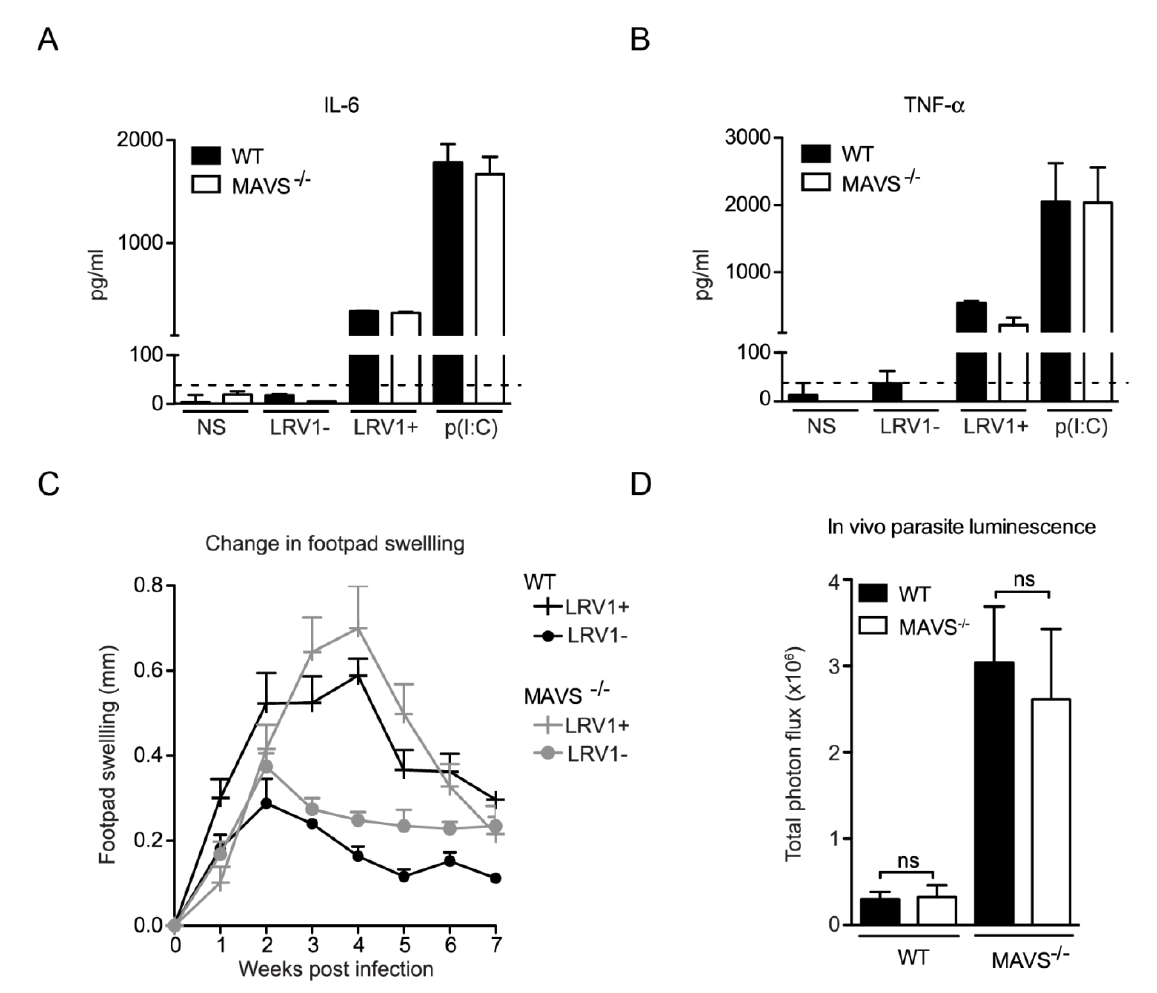
FIGURE 1: LRV1 does not activate RLR signaling. (A, B) BMDMs from mice deficient in MAVS and their C57BL/6 WT counterparts were in- fected with LgyLRV1+ or LgyLRV1- parasites or stimulated with a synthetic TLR3 ligand, poly(I:C). After 24 hours, the NF-  B cytokines, IL-6 (A) and TNF-α (B) in BMDM supernatant were quantified by ELISA. (C, D) MAVS -/- and C57BL/6 WT mice were infected with LgyLRV1+ or LgyLRV1- parasites in their hind footpads. (C) Weekly lesional swelling was monitored as a proxy for disease progression. (D) At the peak of infection (4 weeks), parasite burden was measured by in vivo luminescence, by injecting mice intra-peritoneally with 15 mg/kg luciferin. Data is representative of a minimum of three independent experiments, using at least five mice per condition, and showed as mean ± SEM. Significance tested by Student’s t-test (bar graphs) or one-way Anova (disease score), ns: